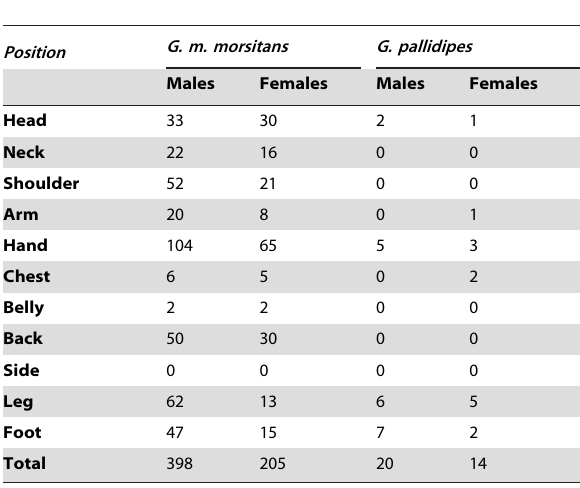
Comparison with standard samples. Despite the above variations in the sex compositions of samples of flies probing men, Table 2. Numbers of tsetse alighting on various parts of men.